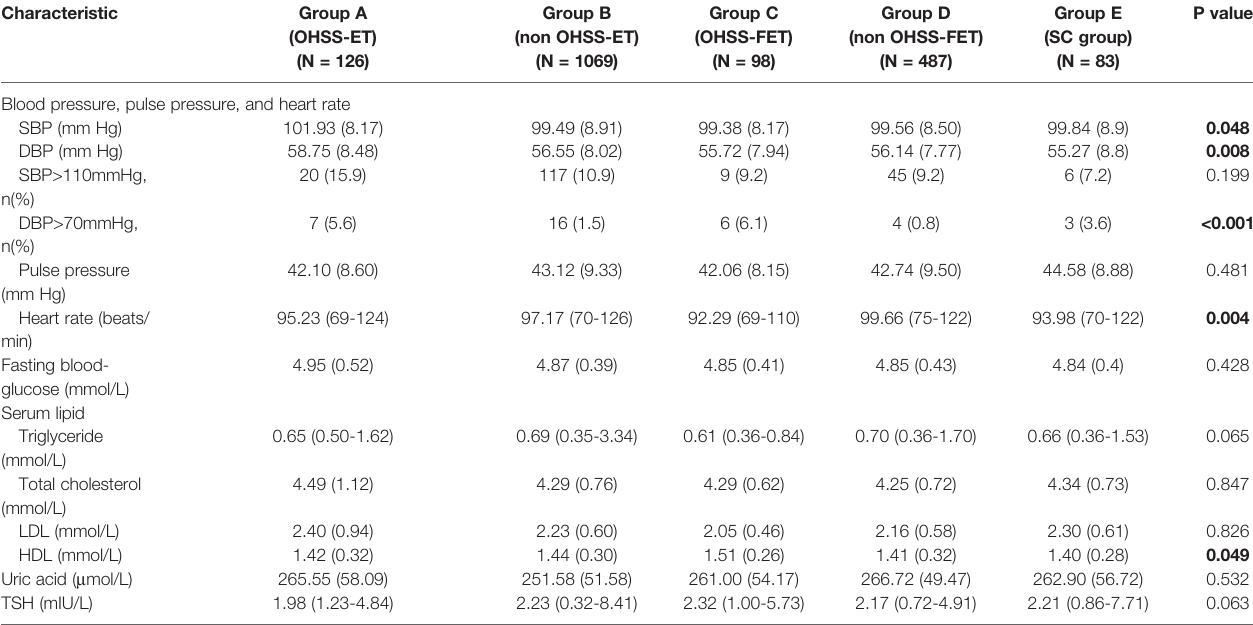
TABLE 3 | Blood pressure (in mmHg) and metabolic function for 3 to 6-year-old singletons born after IVF/ICSI with OHSS-ET (Group A), non OHSS-ET (Group B), OHSS-FET (Group C) or non OHSS-FET (Group D) and SC (Group E).